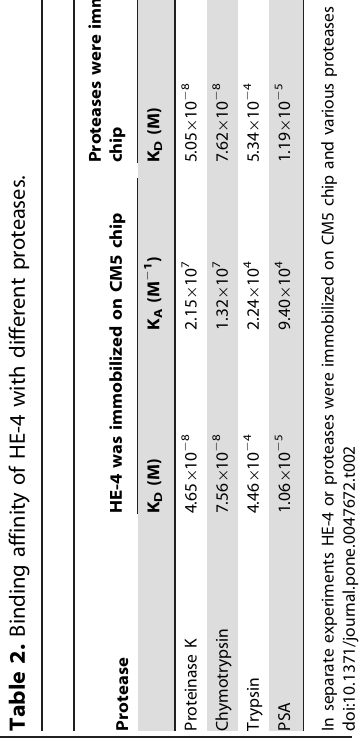
Figure 5. Blue native gel of HE-4 after 2 hr. incubation with different proteases. Proteases and HE-4 alone were also run to compare with the complexes formed with them. 1: Marker 45 kDa Ovalbumin, A: HE-4, B: Trypsin, C: Trypsin + HE-4, D: Chymotrypsin, E: Chymotrypsin + HE-4, F: Proteinase K, G: Proteinase K + HE-4, H: PSA, I: PSA + HE-4, J: Pepsin, K: Pepsin + HE-4, L: Papain, M: Papain + HE-4. critical residues in primary sequence. Factors such as the overall structure of the domain, exposure of some specific amino acids and types of residues lining the active site may be more vital, and contribute to the activity as may be true in this study.